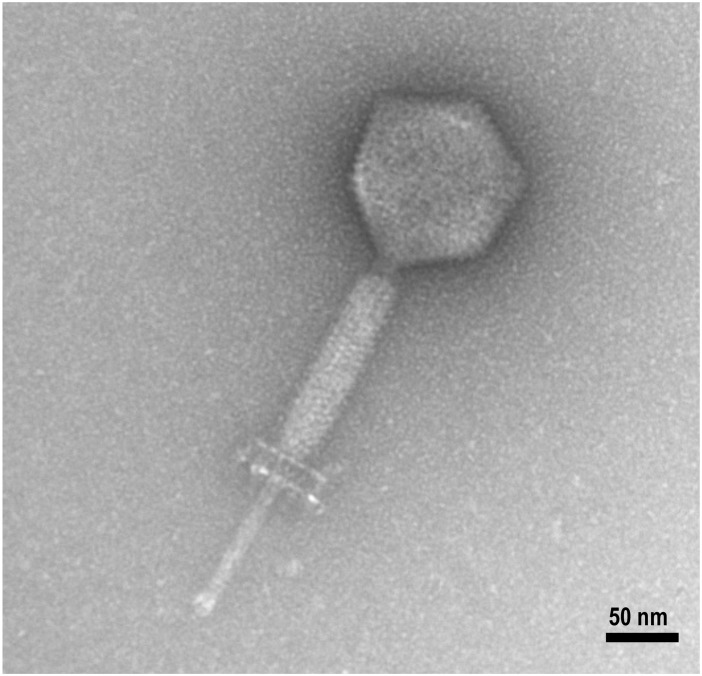
Electron photomicrograph of phage 156. Phage particles were prepared, negatively stained, and examined under the electron microscope as described in the Section “Materials and Methods.” The scale bar represents 50 nm.